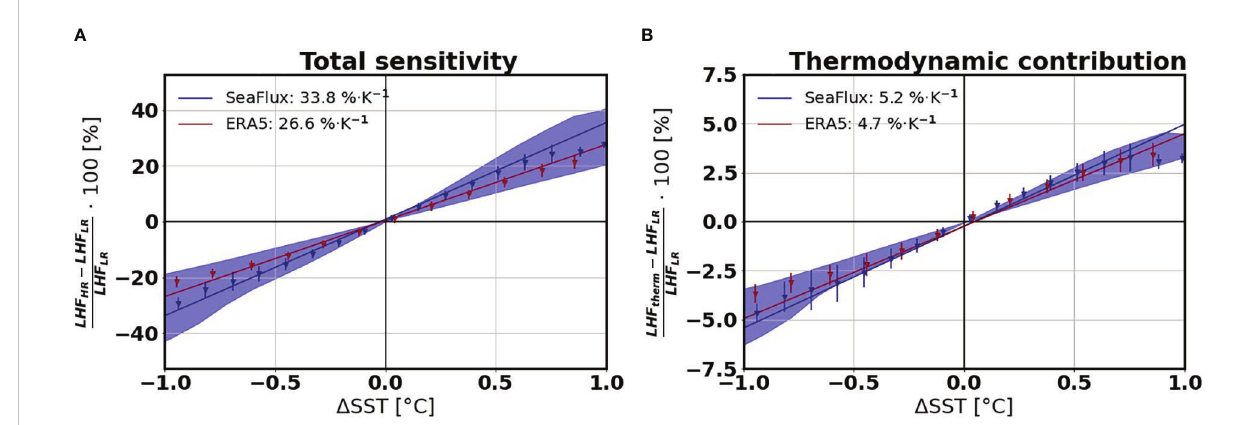
FIGURE 7 Binned scatter plot and linear regression between D SST and the LHF relative error when (A) all the input COARE3.5 variables are downscaled (LHF HR ) and (B) when D SST is only added to T 2m and SST. SeaFlux results are represented in dark blue and the ERA5 output in dark red. Data are taken for the 2008-2018 DJF season and are binned in 0.1°C-wide D SST intervals. The mean value of each bin is represented with dots and the error bars illustrate the standard deviation of each bin. The slopes of the regression lines are provided in the upper left side of each panel. In both panels, the shading indicates the lower and upper limits of the LHF sensitivity to SST obtained when the downscaling (in A ) and correction (in B ) of the COARE3.5 input variables is performed only over the OOR and ECR respectively for SeaFlux. The ERA5 ECR and OOR LHF sensitivity to SST results are not included to facilitate